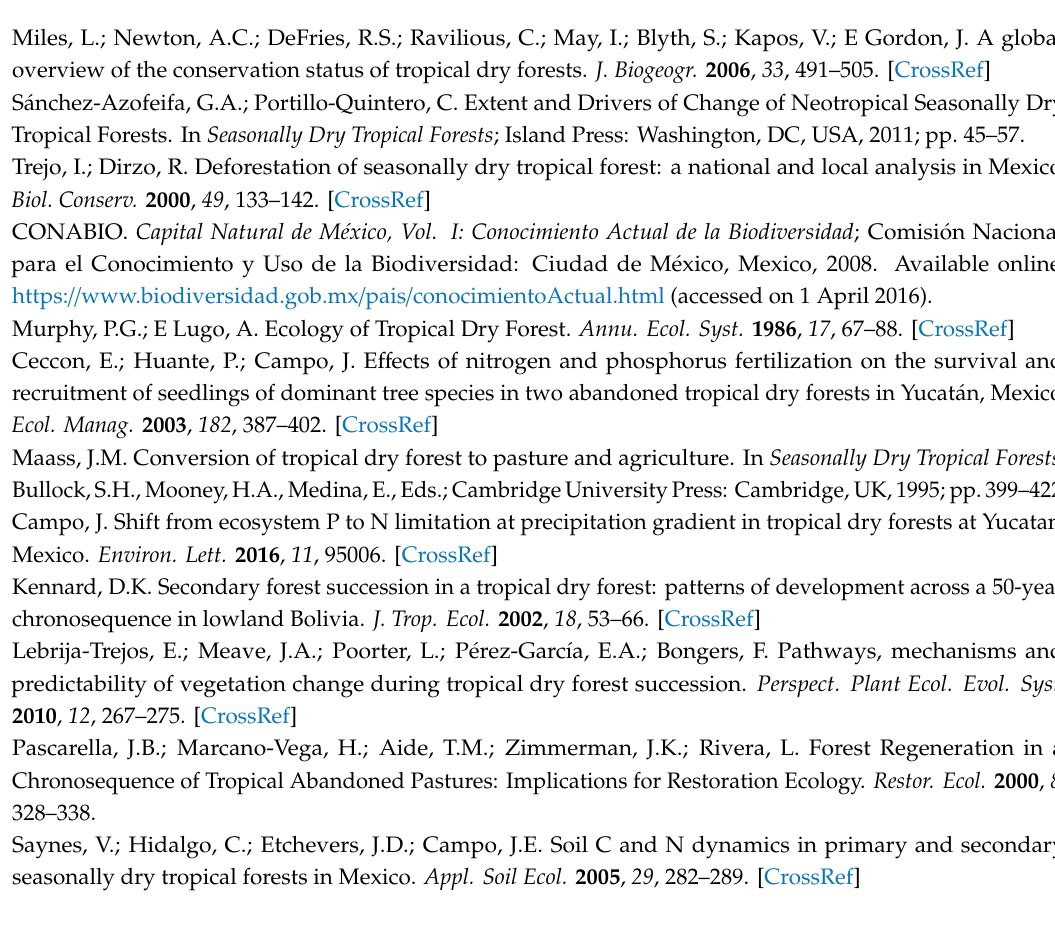
properties for 2014 to PCA axes, Table S4: Pearson correlation coe ffi cient (r) of PCA axes 1 and 2 of soil properties for 2013 and survival (2014, 2016) for six tree species (a) and by growth rank (b), Table S5: Pearson correlation coe ffi cient (r) of PCA axes 1 and 2 of soil properties for 2014 and survival (2014, 2016) for six tree species (a) and by growth rank (b), Table S6: Pearson correlation coe ffi cient (r) of PCA axes 1 and 2 of soil characteristics for 2013 and 2014 and height lnRGR for six tree species (a) and by growth rank (b), Table S7: Pearson correlation coe ffi cient (r) of PCA axes 1 and 2 of soil characteristics for 2013 and 2014 and diameter lnRGR for six tree species (a) and by growth rank